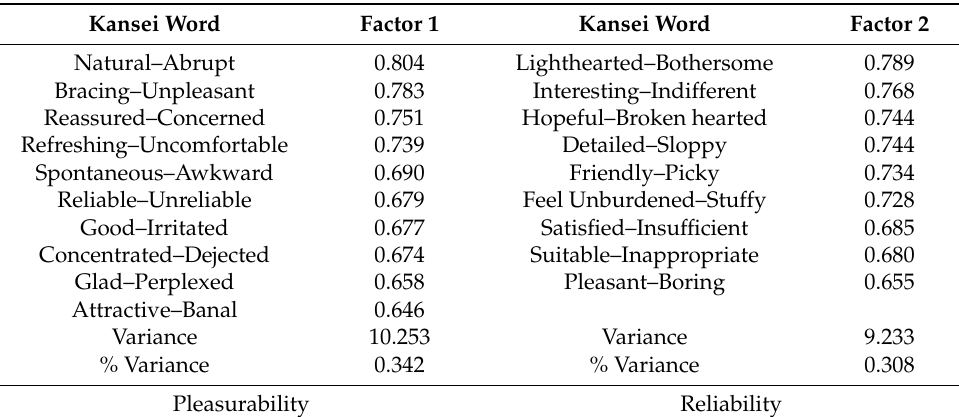
Table 3. Kansei word cluster obtained using factor